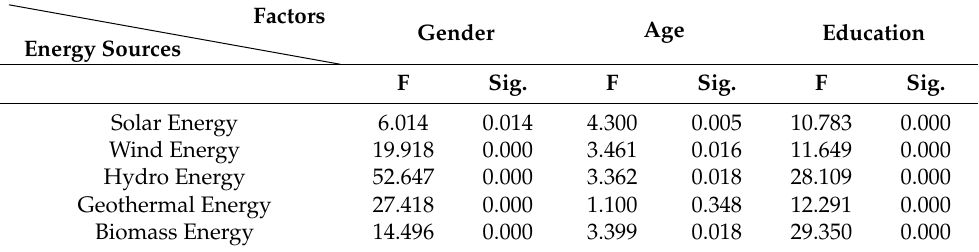
Table 10. Anova renewable energy sources with